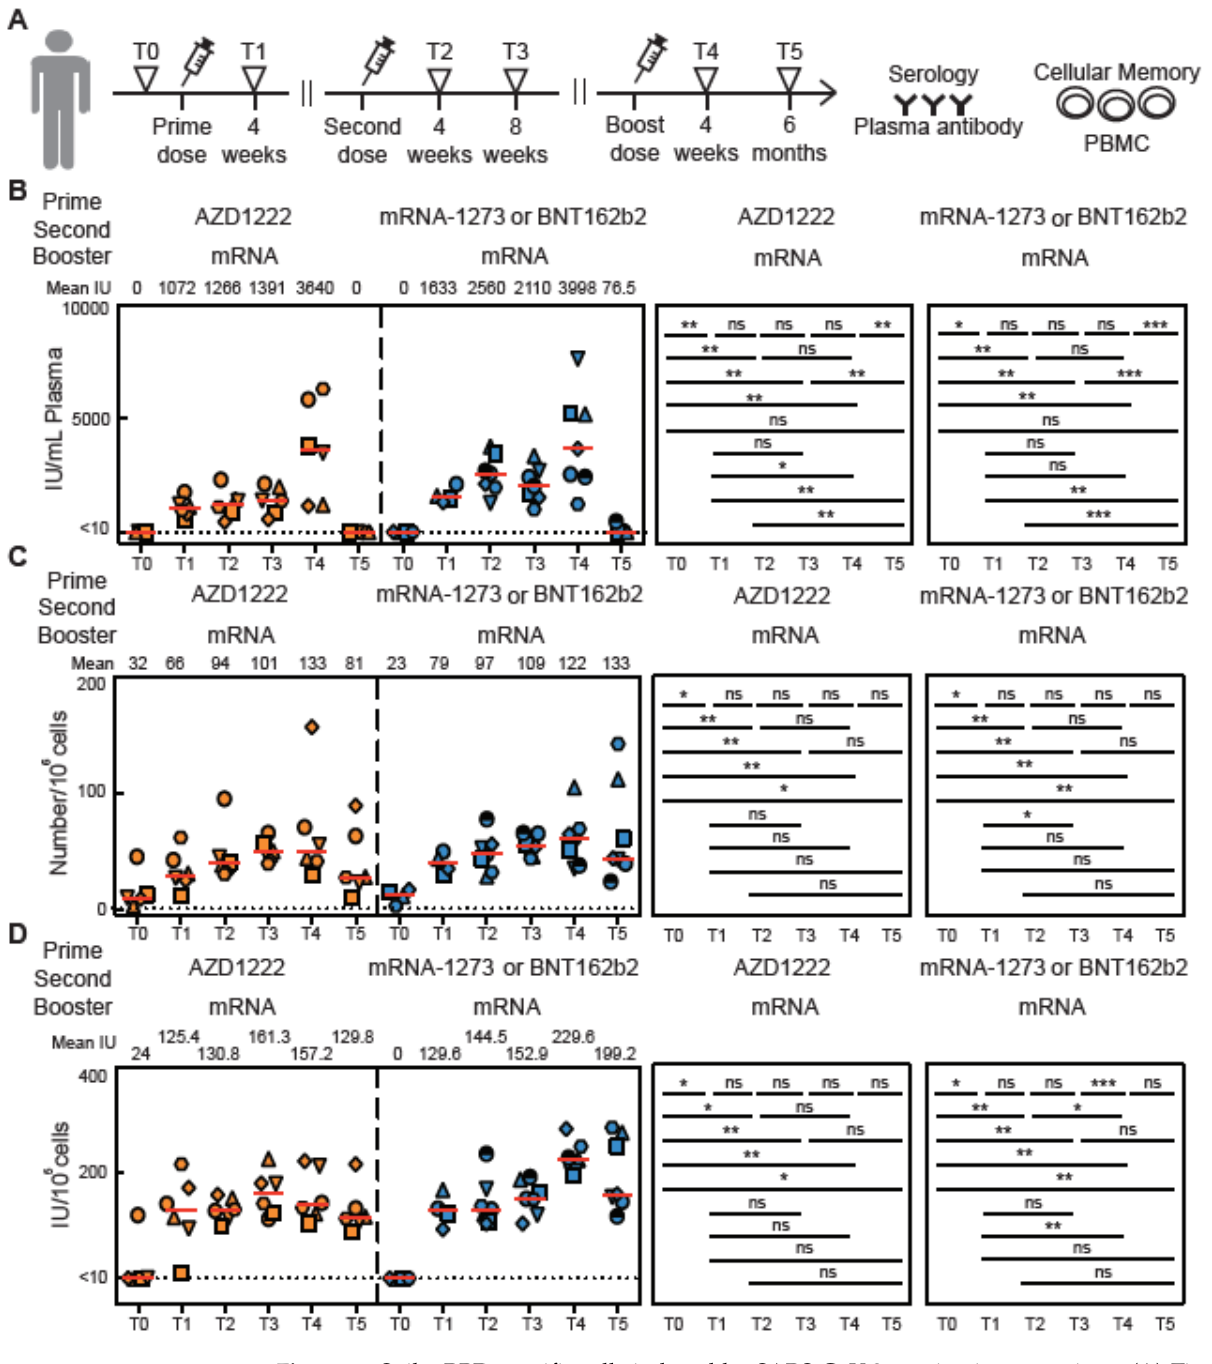
Figure 5. Spike-RBD-specific cells induced by SARS-CoV-2 vaccination over time. ( A ) Timeline for blood draws for analysis of nAbs in plasma, the secretion from stimulated PBMCs, or cellular identification with the MiSelect R II. T4 was 4 weeks after a 3rd vaccination, while T5 was a blood draw 6 months later. ( B ) Concentration of neutralizing anti-spike-RBD IgG antibodies in plasma samples from vaccinated subjects over time. ( C ) Total number of spike-RBD-specific MBCs in PBMC samples from all vaccinated subjects for each time point. ( D ) Concentration of neutralizing anti- spike-RBD IgG antibodies in culture supernatant over time from PBMC stimulated with R848, IL-2, IL-21, sCD40, and WT-RBD. The error bar indicates the median. Statistics were calculated using the non-parametric Mann – Whitney test. The dotted line indicated the limit of detection (LOD) for the assay. * p < 0.05; ** p < 0.01; *** p < 0.001; ns, no significant difference.